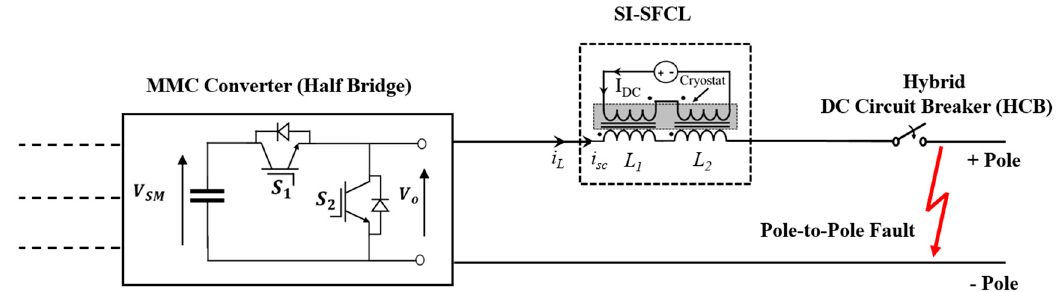
Figure 4. Case 2: Protection scheme composed of HB-MMC, SI-SFCL and HCB.